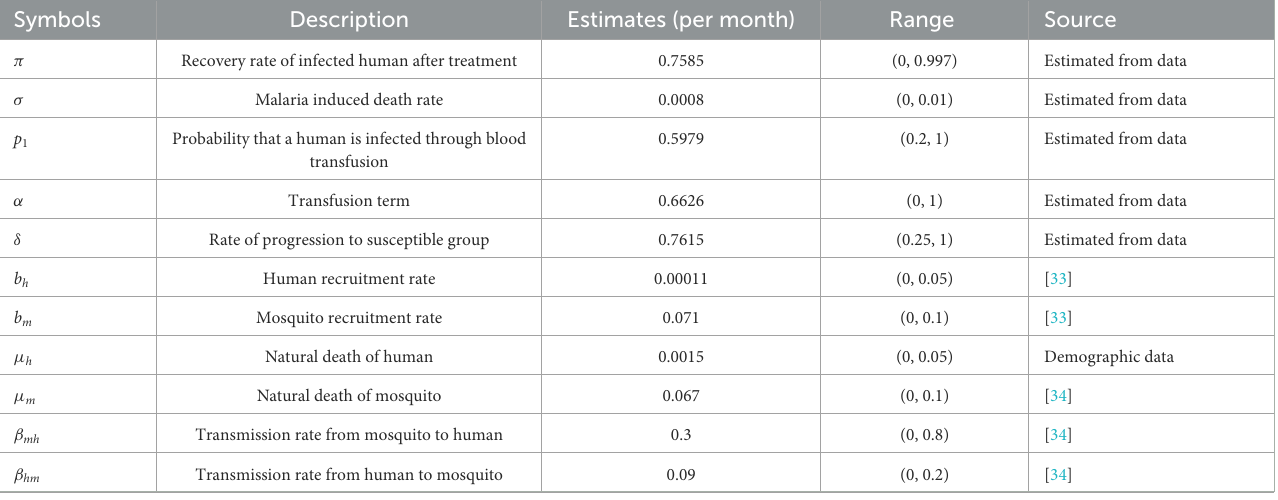
TABLE 1 Parameters and their